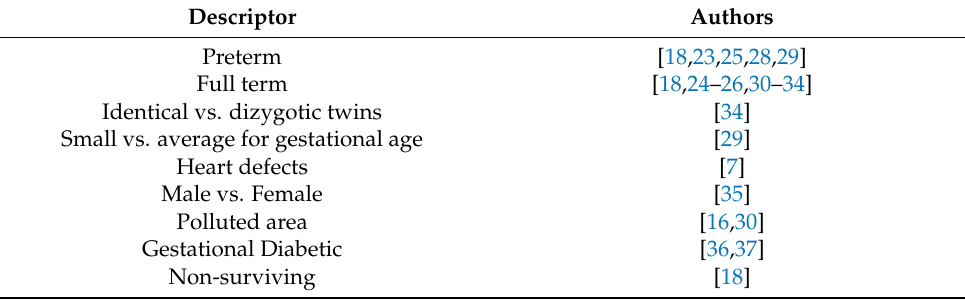
Table 1. Description of cohorts.